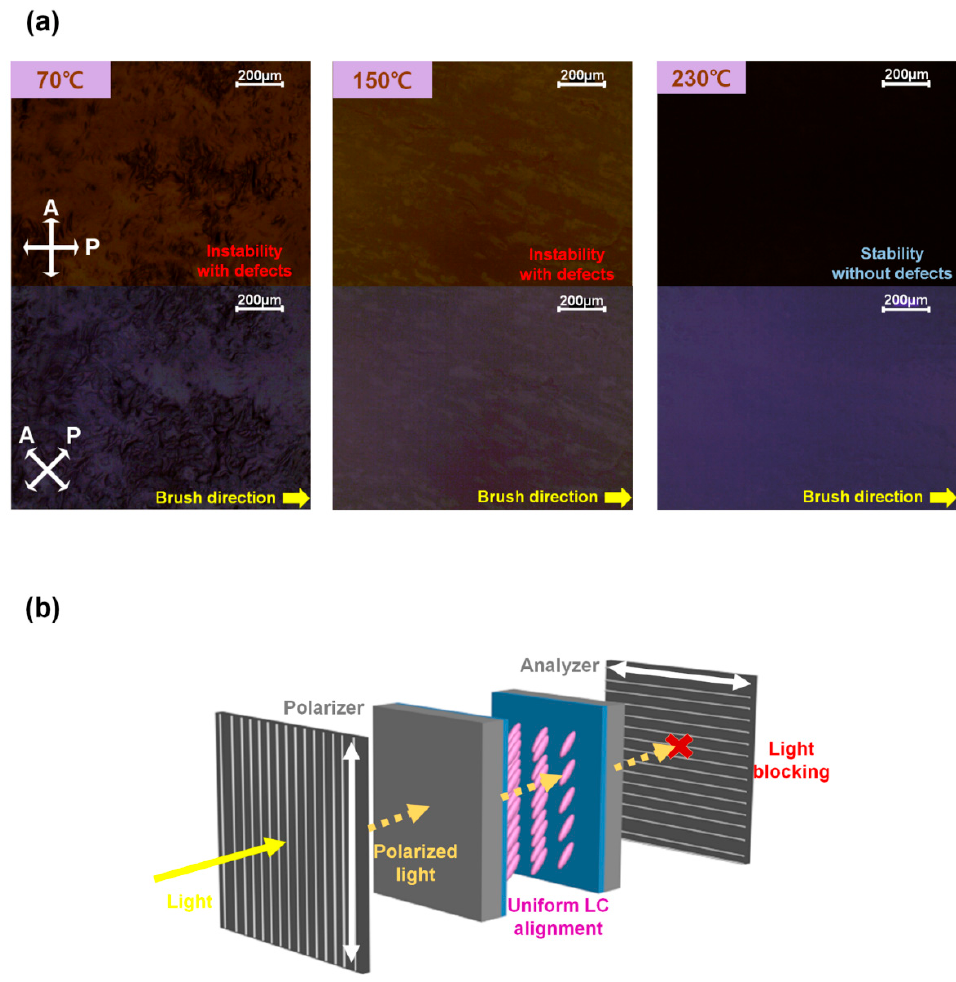
Figure 5. ( a ) Polarized optical microscopy results of anti-parallel liquid crystal (LC) cells made from brush-coated nickel yttrium oxide films cured at 70, 150, and 230 °C. The analyzer (“A”) and polarizer (“P”) directions are denoted by white arrows. ( b ) Schematic of light blocking process with uniformly aligned LCs in the cell.